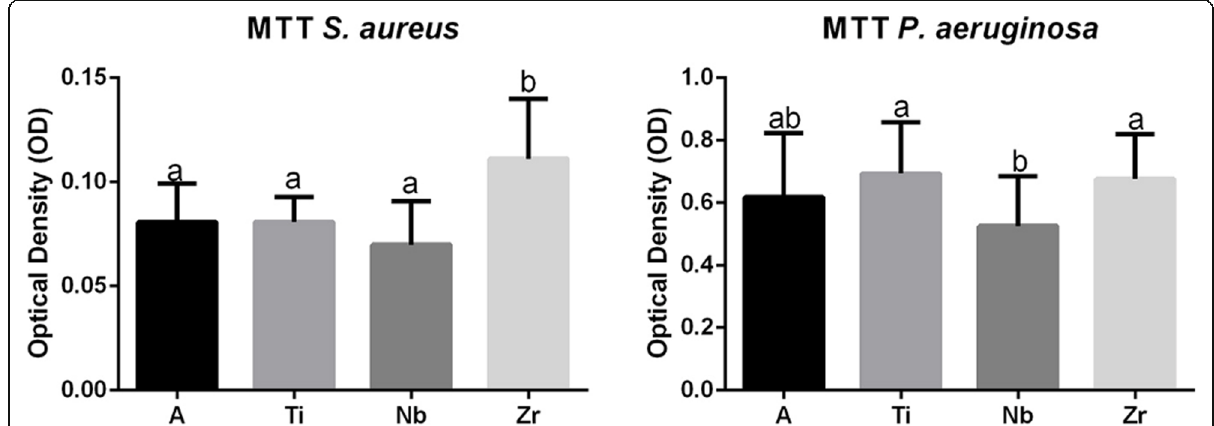
Fig. 7 Nb group exhibited the lowest amount of S. aureus biofilm with statistical difference (a/b) from the Zr group, which presented the highest biofilm formation and differed statistically (a/b) from all groups ( p < 0.05). For P. aeruginosa biofilm, the Nb presented the lowest biofilm values with statistical difference (a/b) from the Ti and Zr groups ( p < 0.05). The Ti group showed the highest biofilm formation result, differing statistically (a/b) only from